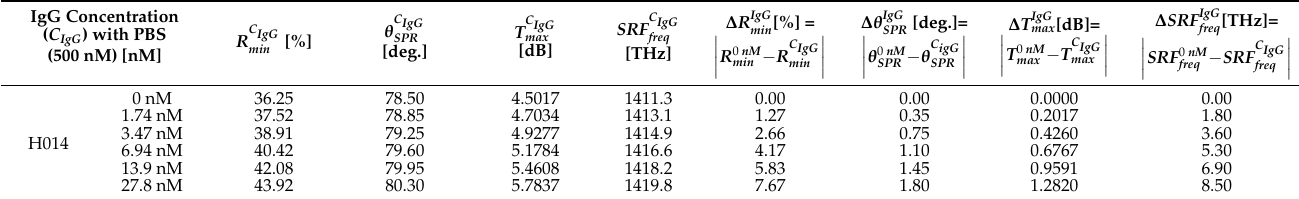
Table 6. ∆ R C RBD , θ C RBD , T C RBD max and SRF C RBD characteristics for different concentrations of IgG (H014) as an analyte. SPR min freq IgG Concentration ( C IgG ) with